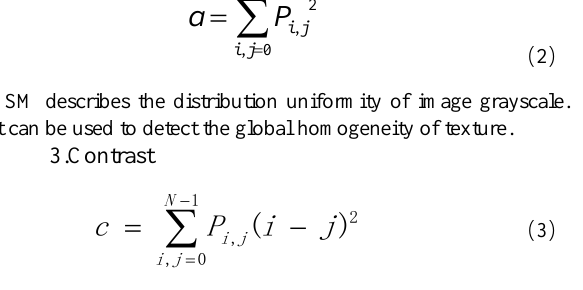
Figure 3. A cartoon profile for